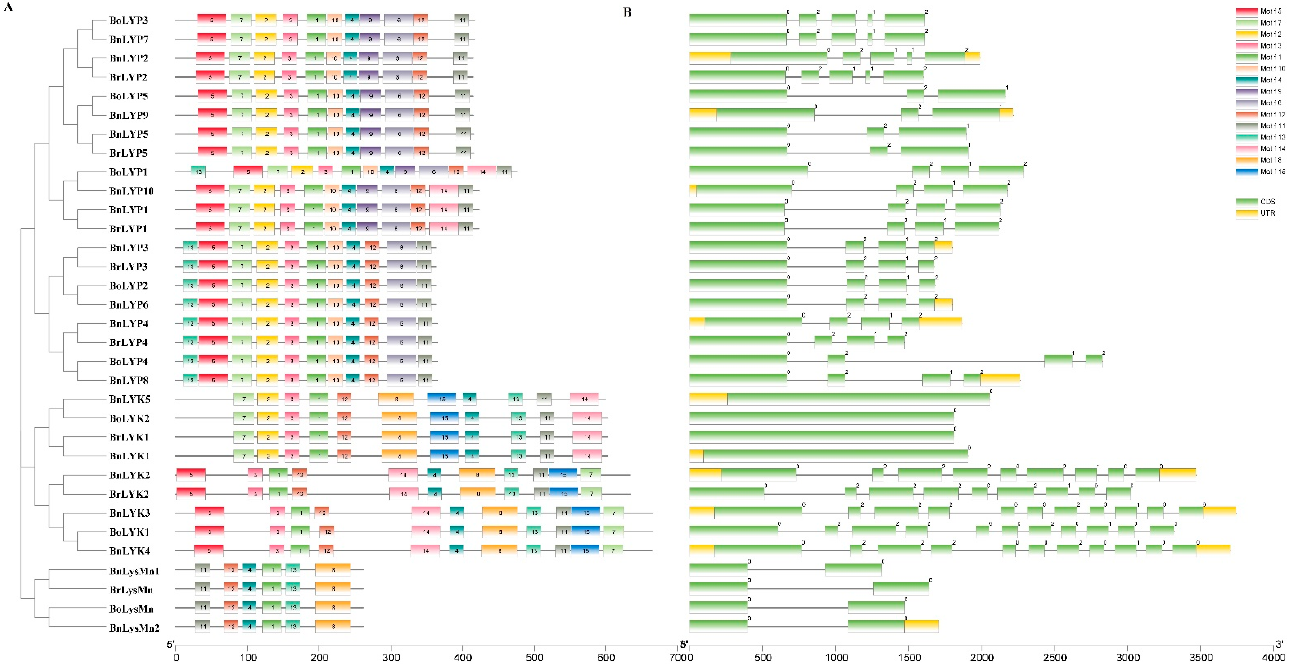
Figure 3. The conserved motifs ( A ) and exon-intron structure ( B ) of LysM-RLK genes in Brassica species. Exons and introns were represented by green boxes and black lines, respectively. Different motifs are shown by different colors Exon-intron structure and Motifs were determined using gene structure display server (GSDS) and MEME online tool, respectively.